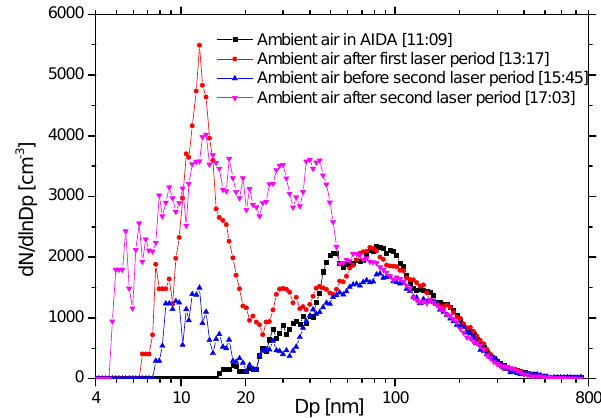
Figure 11. Particle and trace gas formation by laser filaments in ambient air at 283.6 K and 2 Fig. 11. Particle and trace gas formation by laser filaments in ambi- ent air at 283.6K and ∼ 76% RH and 279K and ∼ 90% RH. The ~76% RH and 279 K and ~90% RH. The panels show (a) particle number (red and black line) 3 panels show (a) particle number (red and black line) and mass (blue and mass (blue circles); (b) relative humidity (black line), ozone (blue line), SO 2 (pink line), 4 circles); (b) relative humidity (black line), ozone (blue line), SO 2 and NOx (green line) concentrations; (c) near forward scattering (black line), laser power (red 5 (pink line), and NO x (green line) concentrations; (c) near-forward line) and mixing fan operation (grey shaded area). 6 scattering (black line), laser power (red line) and mixing fan opera- tion (grey shaded area).